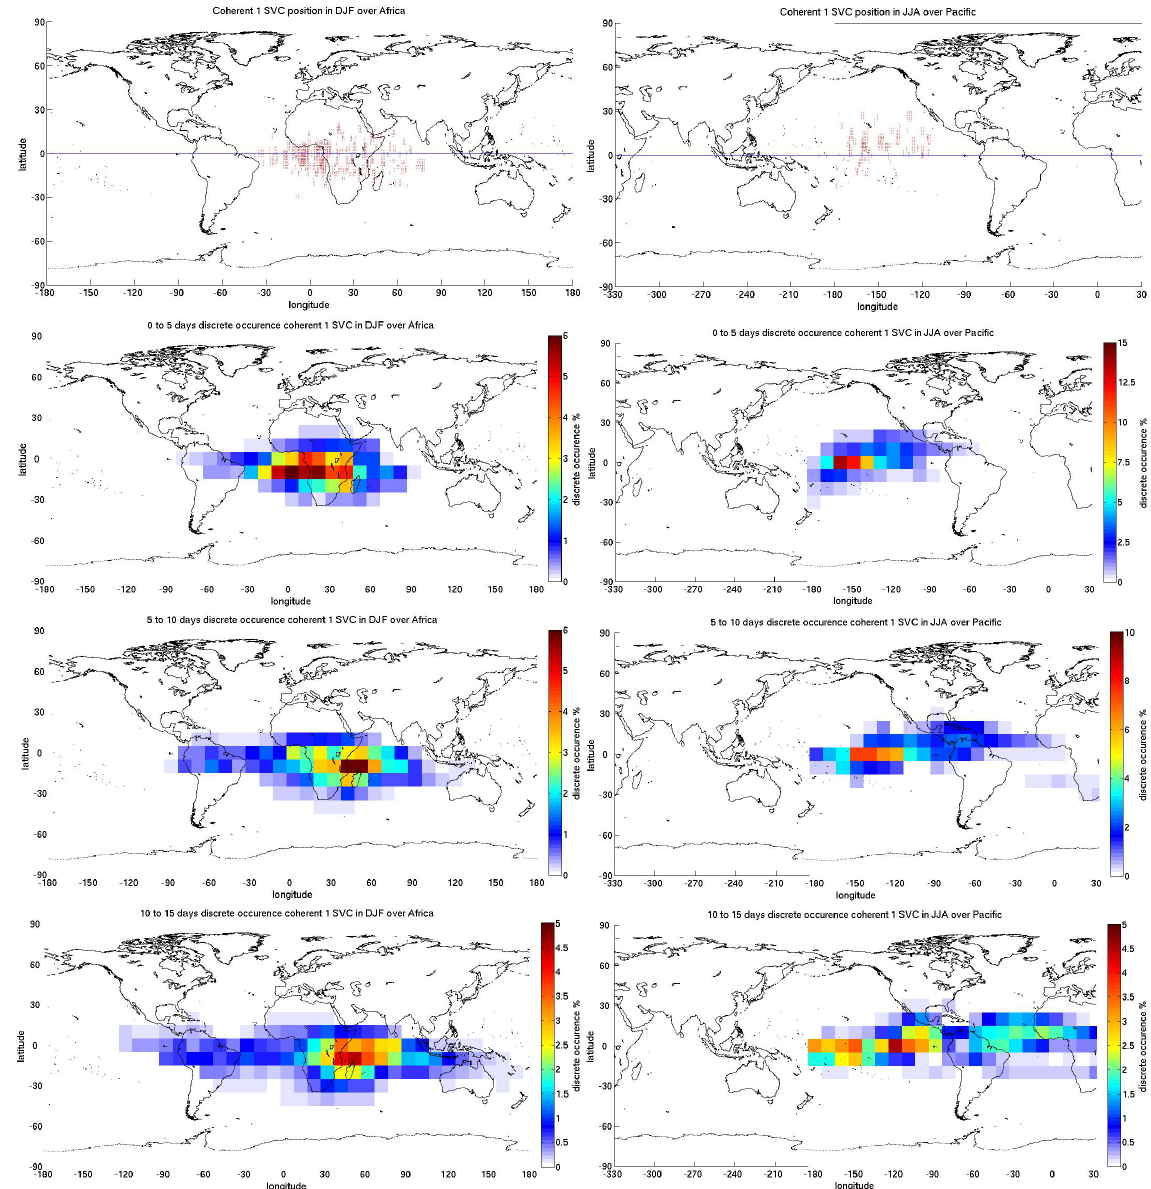
Fig. 9. Top: position of C1 SVC observed over Africa in DJF (left) and Pacific in JJA (right). Second to fourth rows: spatial distribution of C1 back-trajectories over 0–5 days, 5–10 days, 10–15